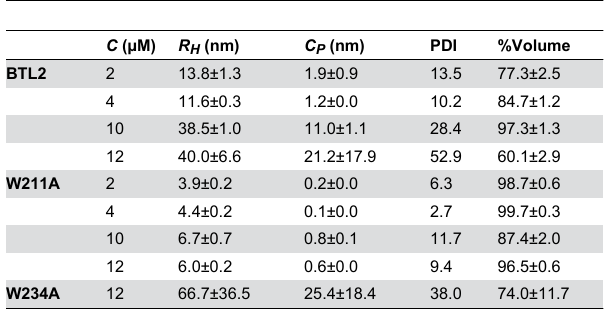
Table 1. Dynamic light-scattering